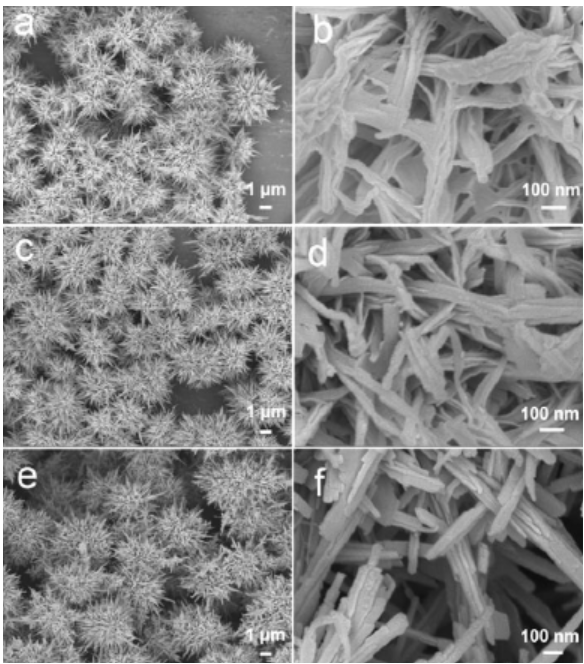
Figure 5. SEM images of the 3D vanadium oxide obtained after different solvothermal reaction time: ( a , b ) VO-0.5 h, ( c , d ) VO-2 h, and ( e , f ) VO-24 h. Reproduced with permission from [32]. American Chemical Society, 2012.